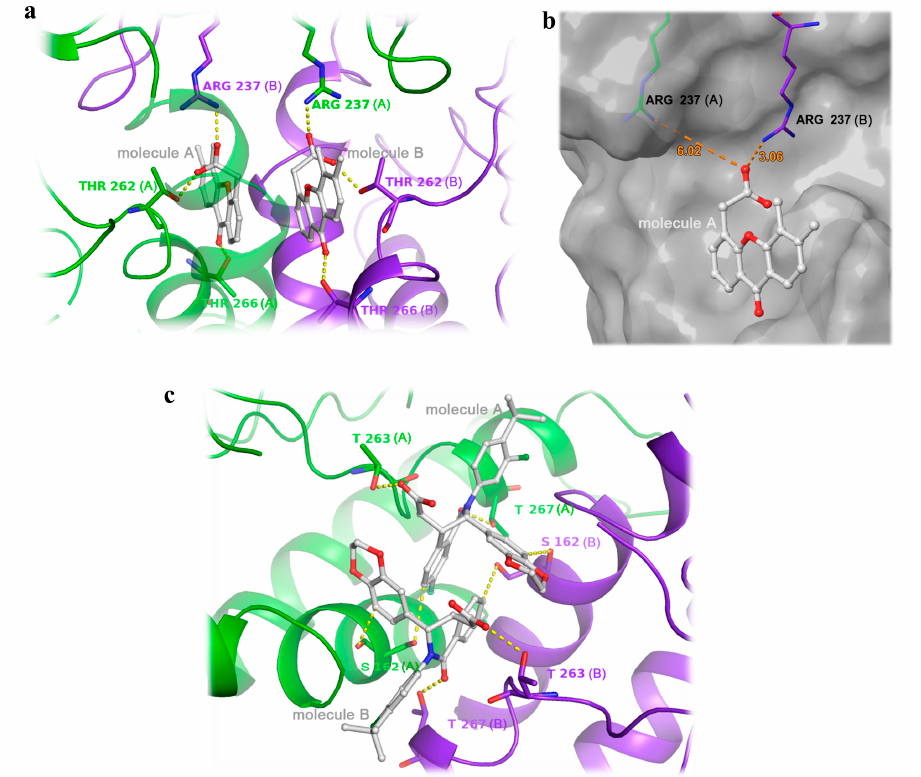
Figure 5. Crystal complexes of DMXAA and Merck 18. ( a ) Intermolecular contacts in the complex of DMXAA and mSTING. The bound DMXAA is shown in gray color, with individual STING subunits in the symmetrical dimer shown in green and purple. The A and B superscripts indicate protein monomer or individual ligand identity. ( b ) Distances between key residues R237A and R237B, respectively, and DMXAA (molecule A). R237A to the carboxyl of DMXAA is 6.02 Å, R237B to the carboxyl of DMXAA is 3.06 Å. ( c ) Crystal structure of Merck 18 bound to hSTING protein (PDB 6MXE) and details of its intermolecular contacts. The bound ligand is shown in gray color, with individual STING subunits in the symmetrical dimer shown in green and purple. The A and B superscripts indicate protein monomer or individual ligand identity.